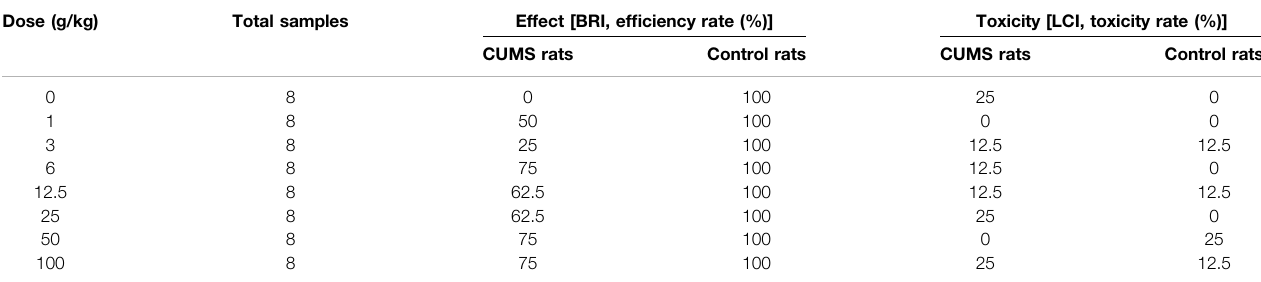
TABLE 4 | The rates of effect and toxicity on CUMS and normal rats administration with PBR. Dose (g/kg) Total